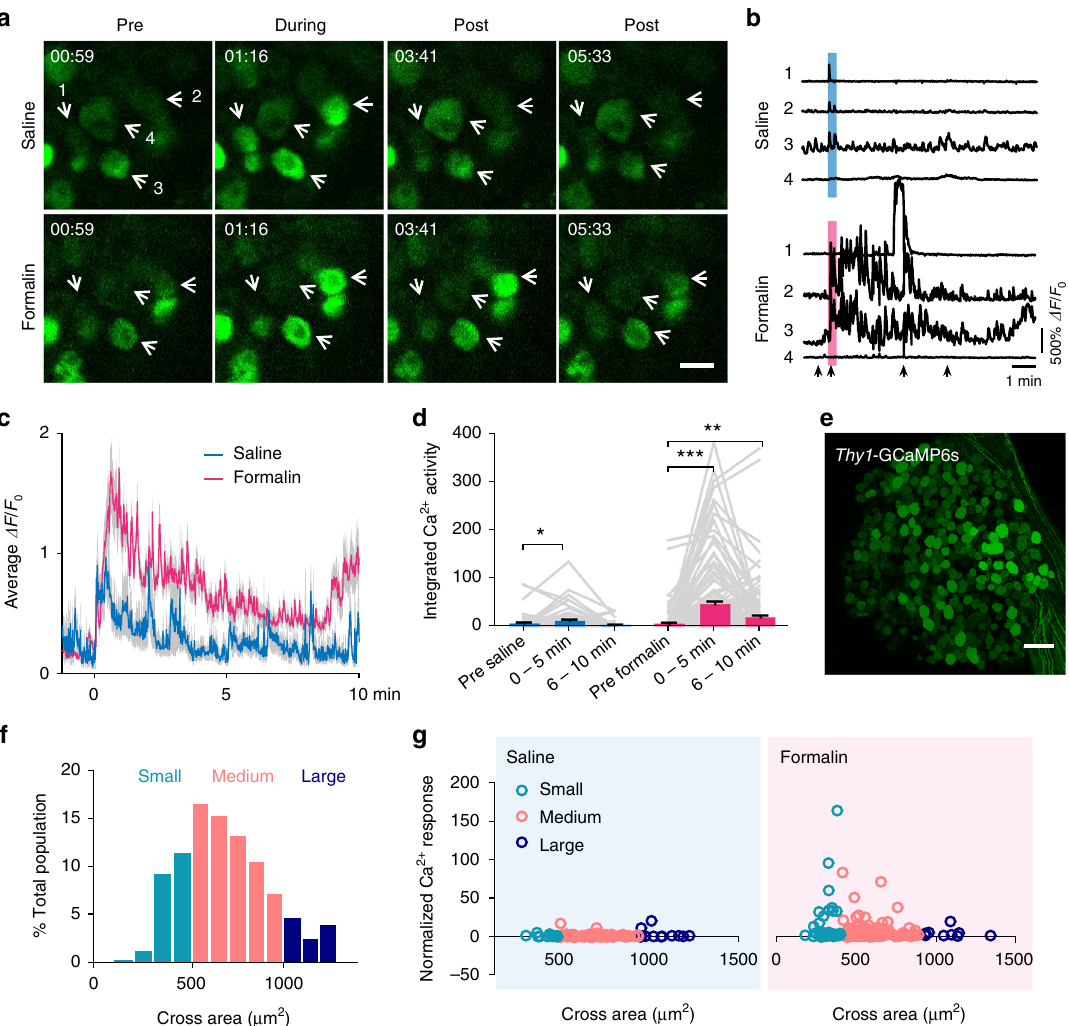
Fig. 4 Plantar formalin injection increases sensory neuron activity in L4 DRG. a Representative images of GCaMP6s-expressing DRG neurons before, during, and at different time points after plantar saline or formalin injection. The time relative to the start of the imaging was marked in a and indicated by arrows in b . Scale bar, 20 μ m. b Ca 2 + traces of indicated neurons in a . Blue and pink box indicates the 20-s saline and formalin injection period, respectively. c Population average Δ F / F 0 of all sensory neurons following saline ( n = 83 neurons from three mice) or formalin ( n = 177 neurons from six mice, of which 83 neurons from three mice were shared with saline group) injection. Blue and pink line denotes the mean value, and gray envelope denotes the s.e.m. d Integrated Ca 2 + activity of sensory neurons before and after saline (pre-saline: 6.13±2.06, 0 – 5min: 11.45±2.71, 6 – 10min: 2.94±0.90; n = 83 neurons from three mice; F 1.9, 127.3 = 6.57, RM one-way ANOVA) or formalin (pre-formalin: 5.88±1.71, 0 – 5min: 46.31±5.45, 6 – 10min: 19.07±3.82; n = 177 neurons from six mice; F 1.8, 288.5 = 40.2, RM one-way ANOVA) injection. e A representative image showing GCaMP6s-expressing sensory neurons in L4 DRG. Scale bar, 100 μ m. f Somatic size distribution of GCaMP6s-expressing neurons in L4 DRG ( n = 3542 neurons from four mice). g Saline and formalin-induced Ca 2 + responses were normalized by baseline activity and depicted as a function of somatic size. Error bars, s.e.m. * P <0.05; ** P <0.01; *** P <0.001; RM one-way ANOVA followed by Dunnett ’ s multiple comparisons test in d . The source data underlying c , d , f , and g are provided as a Source Data fi paired vs. lidocaine-paired side: 202.3 ± 13.0 s vs. 392.3 ± 13.6 s;